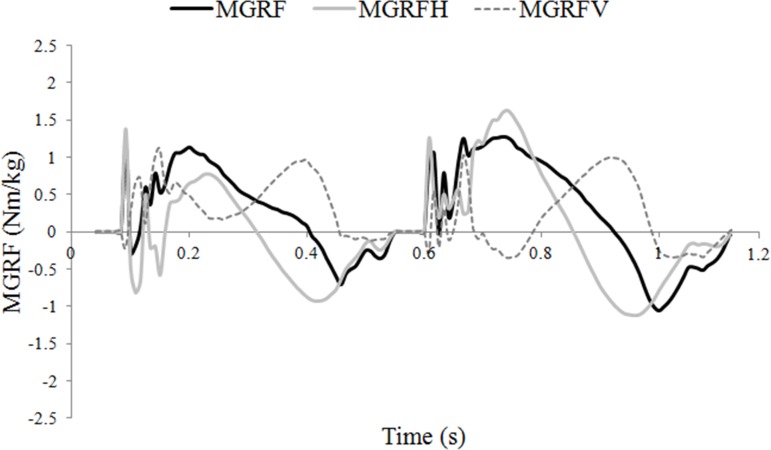
Moments around the center of mass (COM) (Nm/kg) during one stride of passage.MGRF, total moments around the COM due to the effect of the ground reaction forces; MGRFV, moments due to vertical force production; MGRFL, moments due to longitudinal force production.